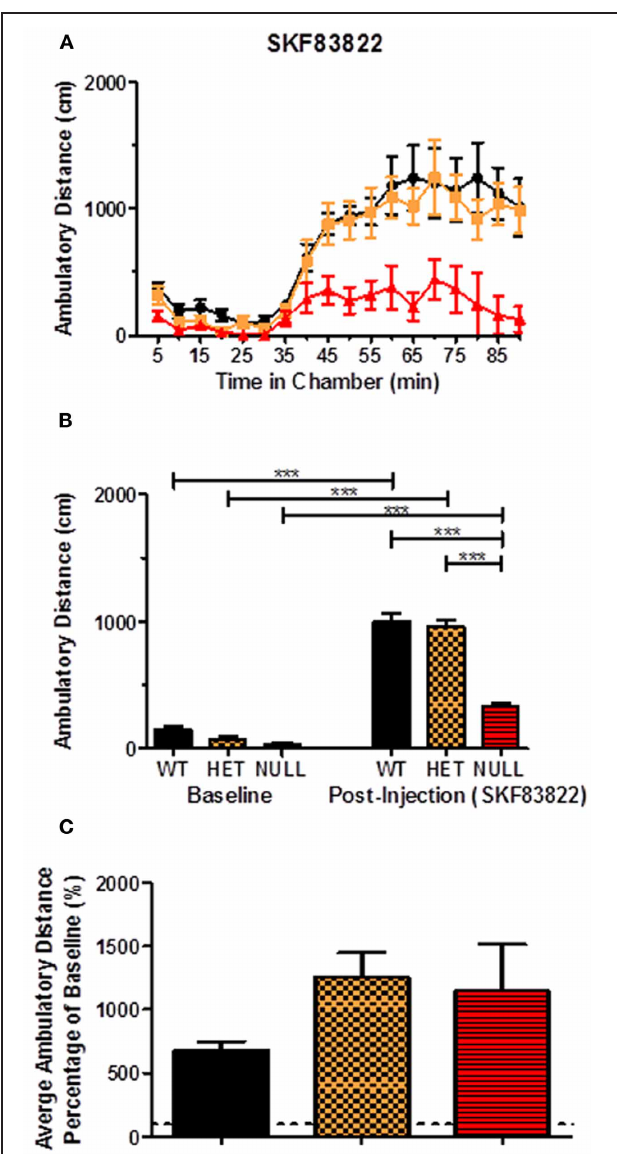
FIGURE 8 | Locomotor response to acute SKF83822. (A,B) represent the ambulatory distance traveled by each genotype in response to an acute injection of the dopamine D 1 receptor agonist SKF83822 (0.4mg/kg; i.p.). There is a significant increase in locomotor activity in each genotype following exposure to SKF83822 [ F ( 5 , 18 ) = 139 . 2, p < 0 . 001]. There is, however, a significant difference between the locomotor response of the knockouts compared to the other two genotypes [ F ( 5 , 18 ) = 139 . 2, p < 0 . 001] without significant changes in the percentage change from baseline between the genotypes (C) . n = 6–12 for each genotype in these experiments. stress in rodent models alters transcript levels of Gnaq (Alfonso et al., 2006); another implication of alterations in G α q signaling in rodent models of depression. It is possible, however, to acti- vate these signaling pathways via other mechanisms including signaling initiated by G α 11 coupling which remains intact in the G α q knockout